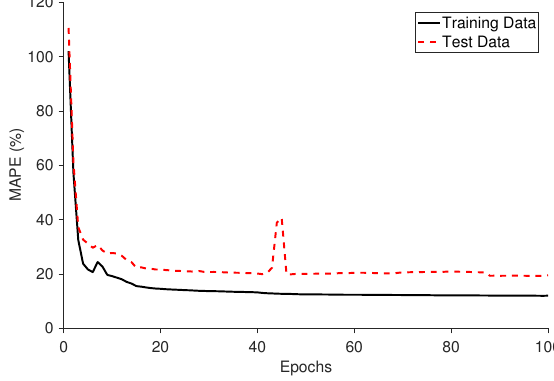
Figure 9. An example of the customer learning curve.